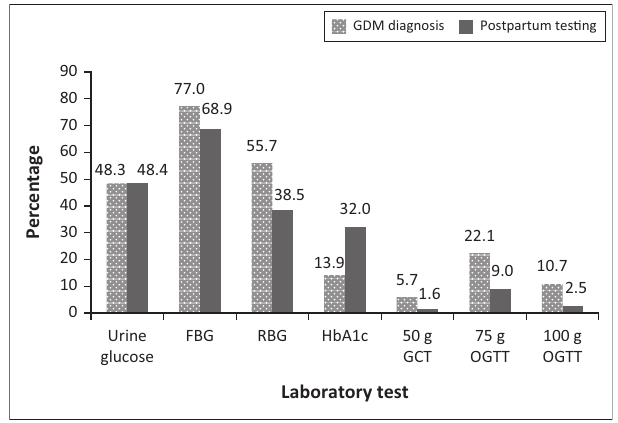
FIGURE 2: Laboratory testing for hyperglycaemia in pregnancy among antenatal healthcare providers in healthcare facilities in Jos North, Plateau state, Nigeria, August to September 2019.